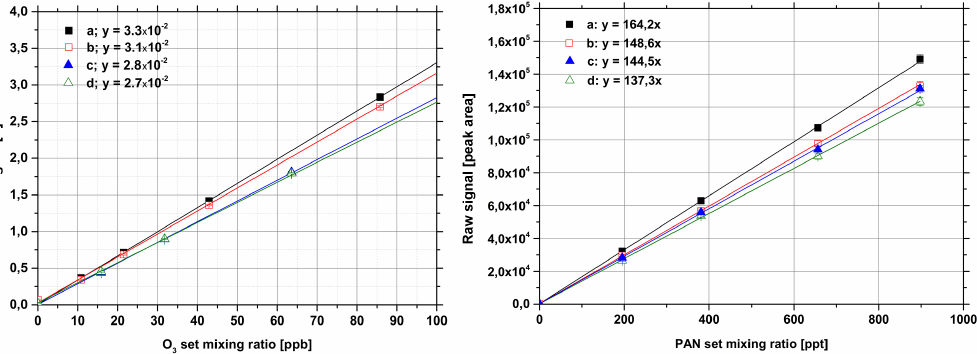
Figure 8. Systematical determination of the O 3 and PAN loss at different locations of the cuvette setup. (a) analyzer directly connect with calibration unit without setup, (b) including teflon pump, (c) including MFCs for gas addition, (d) including cuvettes and valve block system.